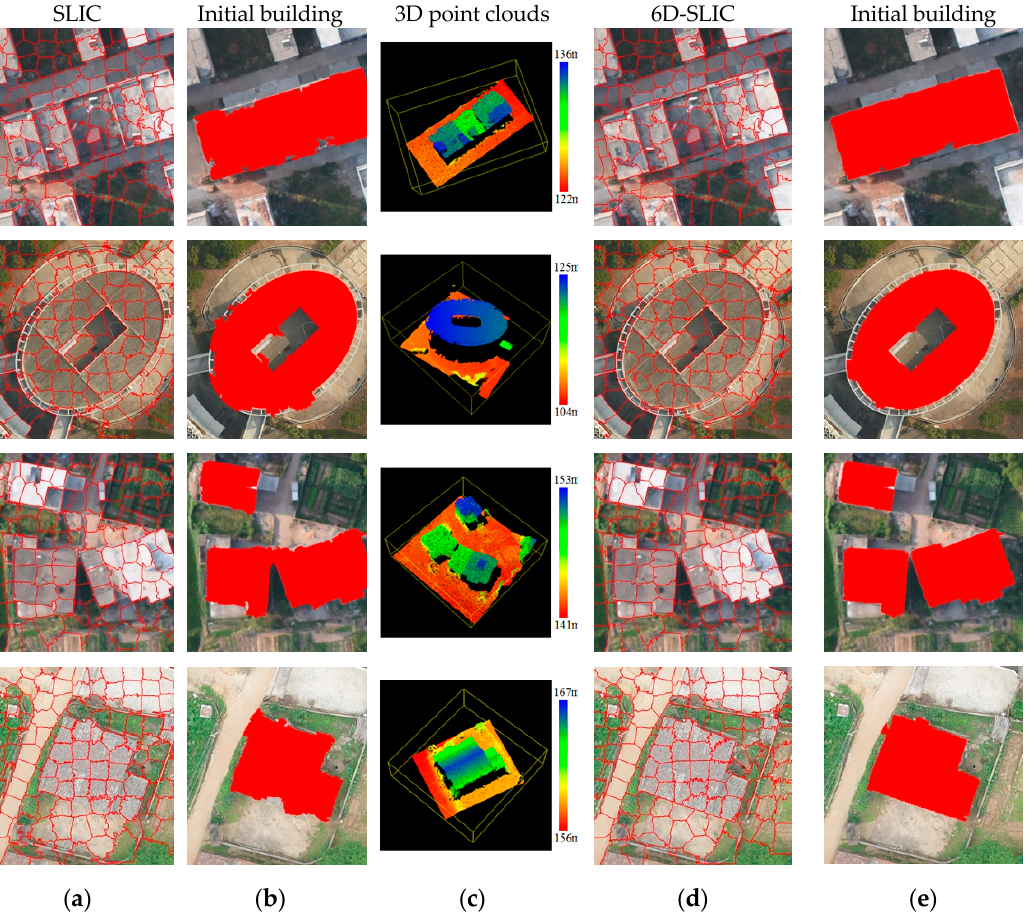
Figure 3. Comparison of building extraction using SLIC and 6D-SLIC algorithms from four building examples corresponding to Figure 2( a ). Columns ( a ) and ( d ) are the superpixels obtained from the SLIC and 6D-SLIC algorithms, respectively. Columns ( b ) and ( e ) are the initial building areas that are shaped by merging superpixels on the basis of approximately equal heights. Column ( c ) shows the 3D point clouds of the four building examples. A high segmentation performance can be achieved when the weight α is set to 0.6.